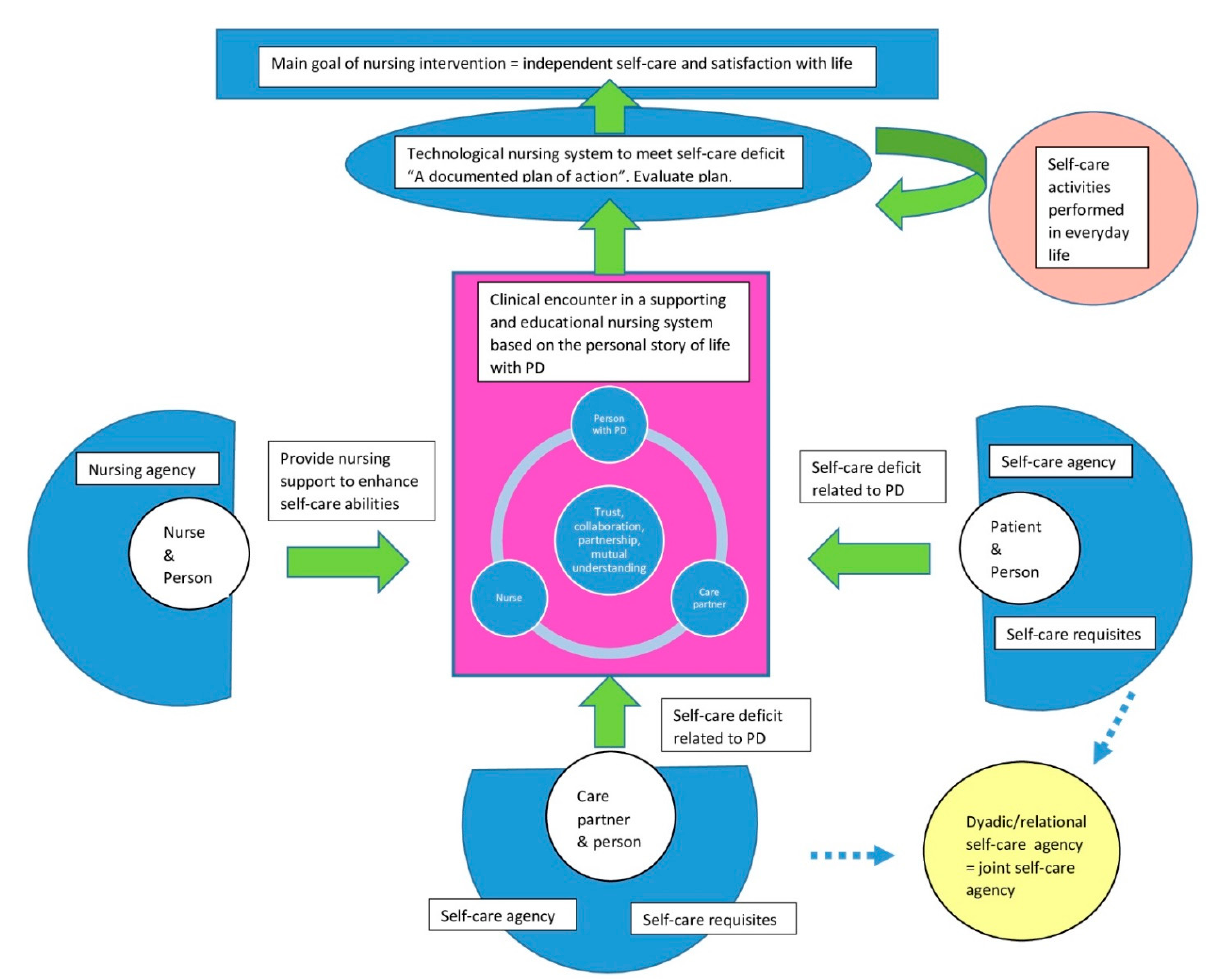
Figure 2. Model of self-management support for persons with long-term conditions in the clinical nursing encounter.